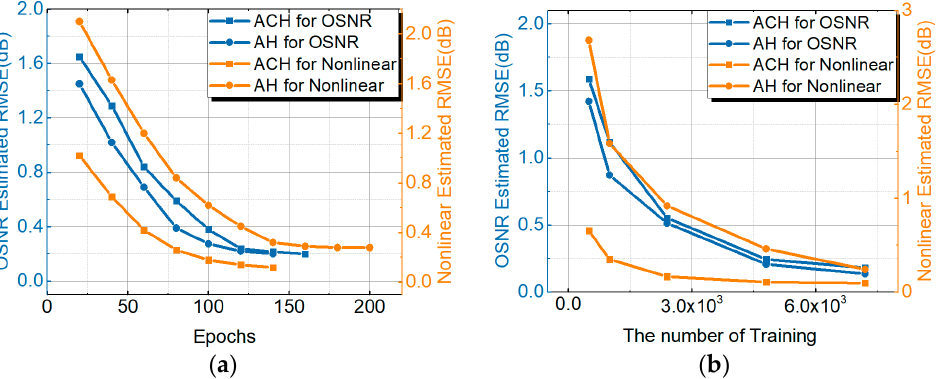
Figure 8. ( a ) Comparison of NL and OSNR monitoring performance between AH MT-ANN and ACH MT-ANN. ( b ) The RMSE monitoring result of OSNR and NL with the training number of AHs and ACHs for PDM-32QAM.